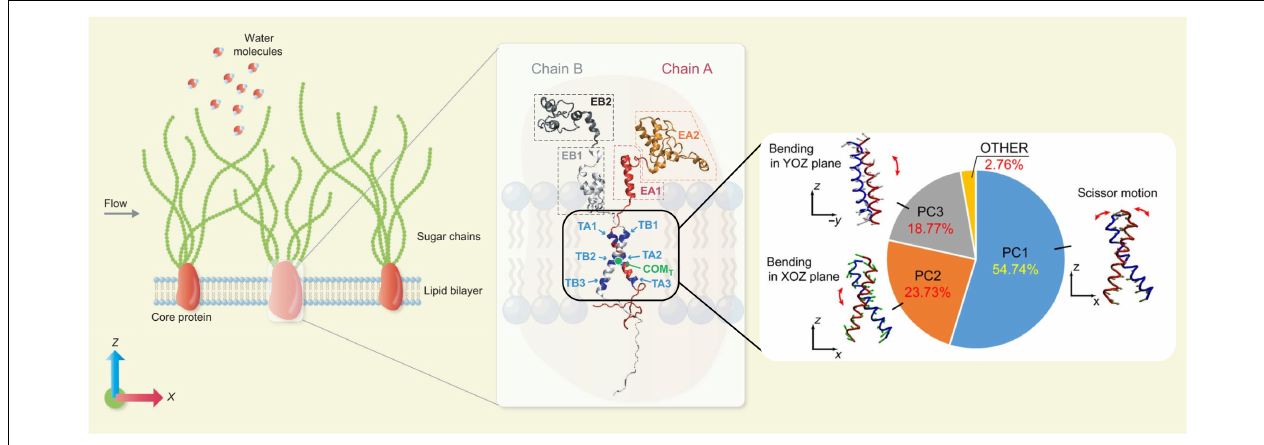
FIGURE 2 | Force transmission mode of Syndecan-4 revealed by MD simulations. (Left) An MD model for EG. (Middle) Secondary structure of Syndecan-4. (Right) Force transmission mode via the transmembrane part of Syndecan-4 (Jiang et al., 2020b; reuse of figure under CC BY 4.0